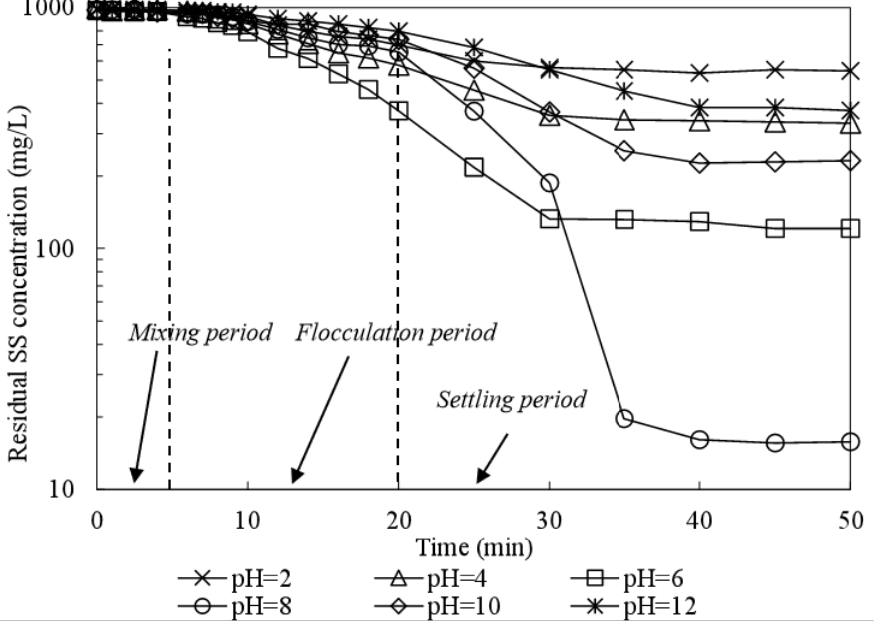
Figure 4. Continuous variation in residual SS concentration of high-grade kaolin suspension samples at different pH values. The mean deviations of the SS concentration values observed were within 5% of the means.